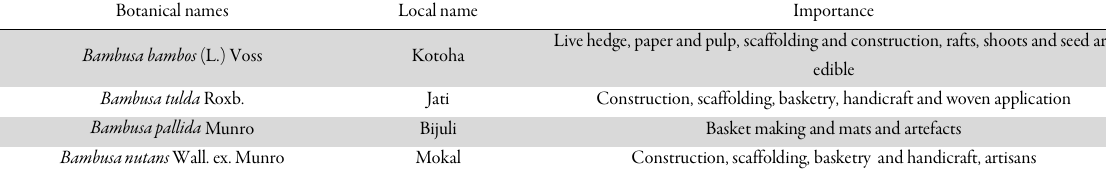
Table 1. Selected bamboo species along with their local name and economic uses in